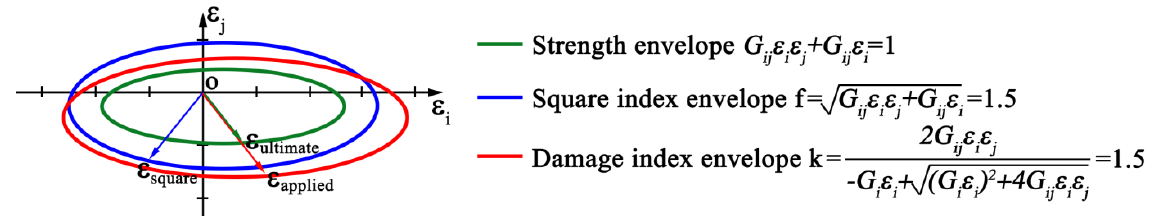
Figure 5. Comparison between the damage index k envelope and the square index f